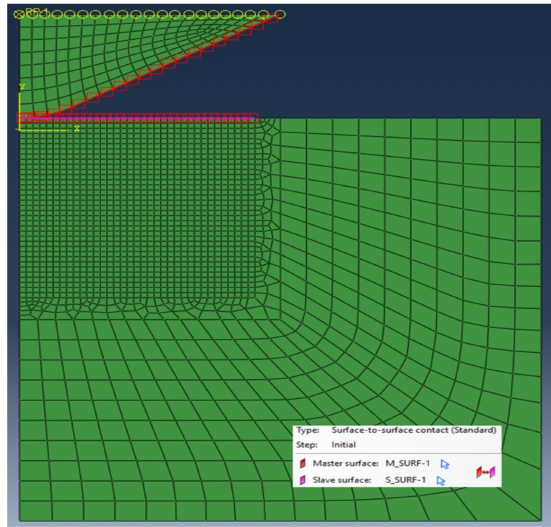
Figure 3. Finite element mesh and contact model of